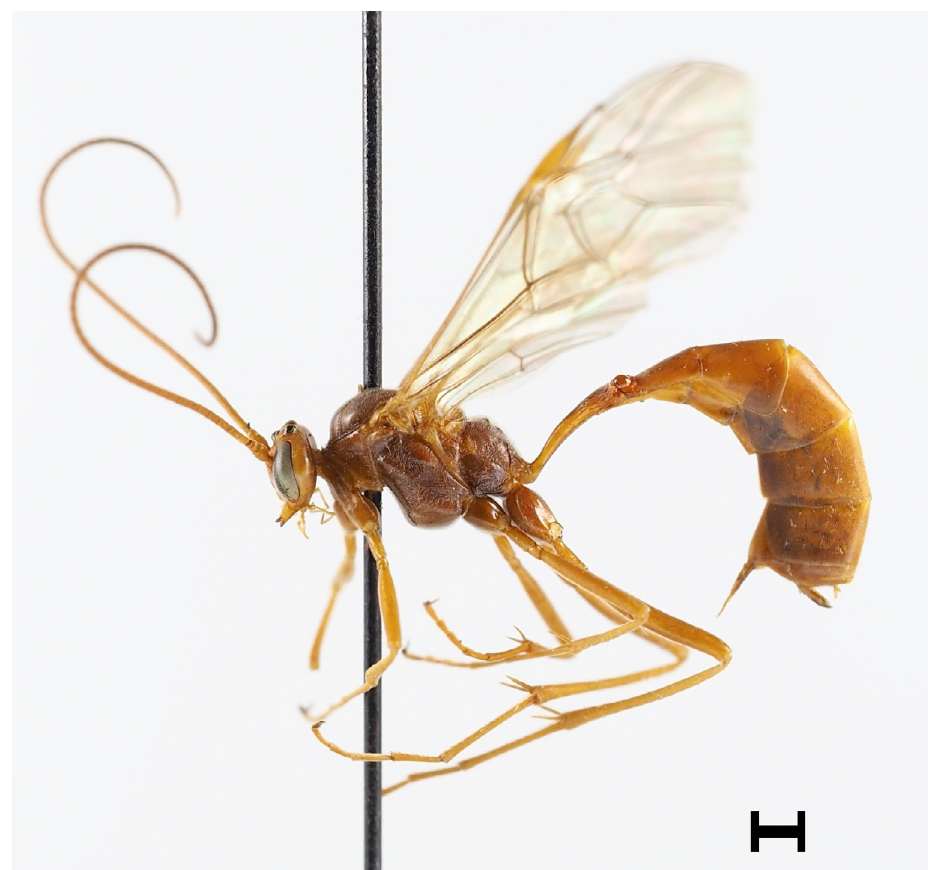
Fig. 42. Ophion subarcticus Hellén, 1926, ♀. Scale bar = 1